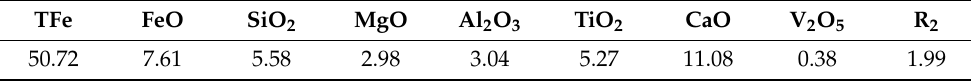
Table 1. Main chemical composition of the VTM sinter, wt%.